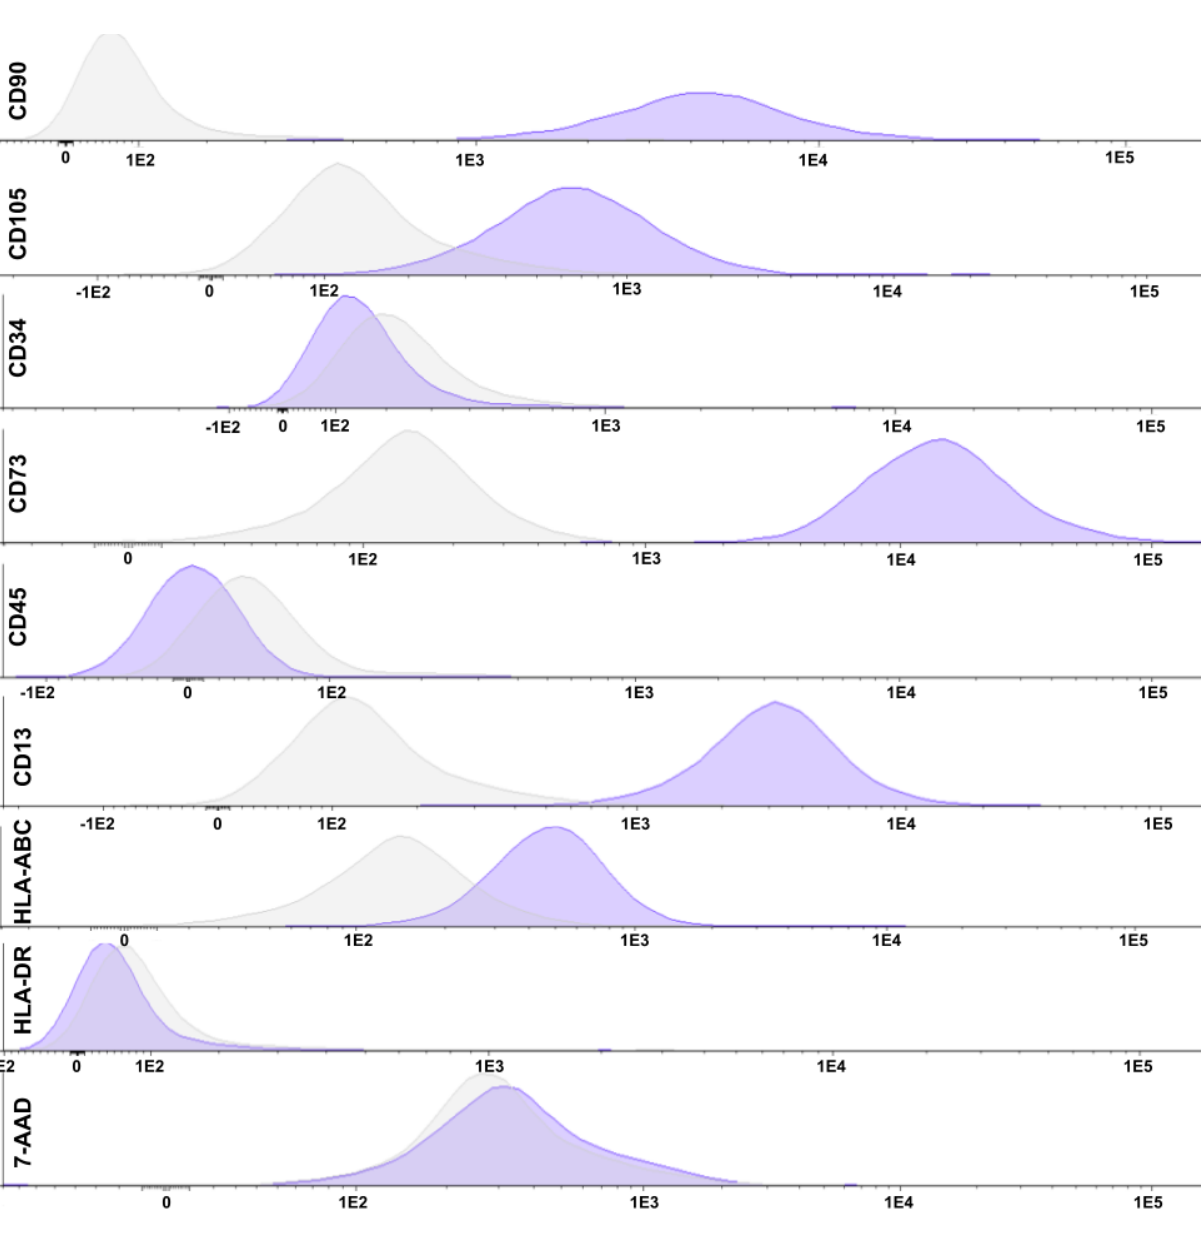
Figure 1. Flow cytometry histograms. The histograms represent the cytometry of the WJ-MSC (sample C6) for the markers CD34, CD45, CD73, CD90, CD105, HLA-ABC, and HLA-DR, respectively (purple), as well as the isotypic control (gray). 1E2= 1 × 10 2 , 1E3= 1 × 10 3 , 1E4= 1 × 10 4 and, 1E5= 1 × 10 5 .